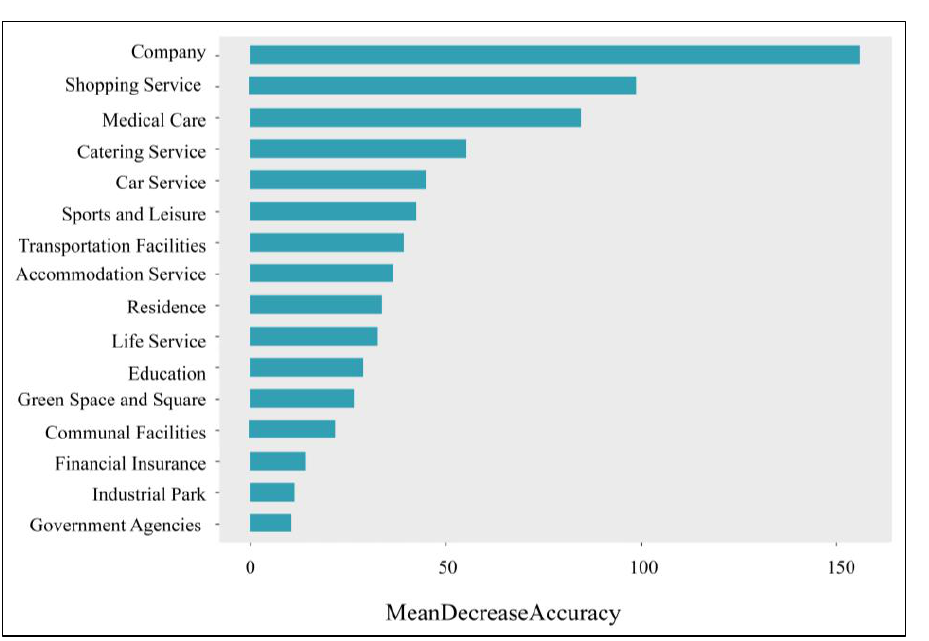
Table 1. Weight index classification table of POI.